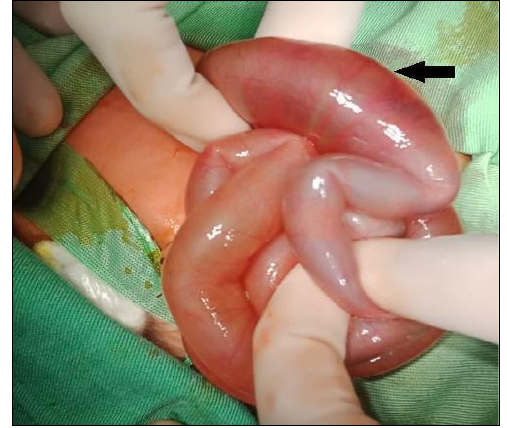
Figure 2: Showing Segmental dilatation of ileum (arrow).